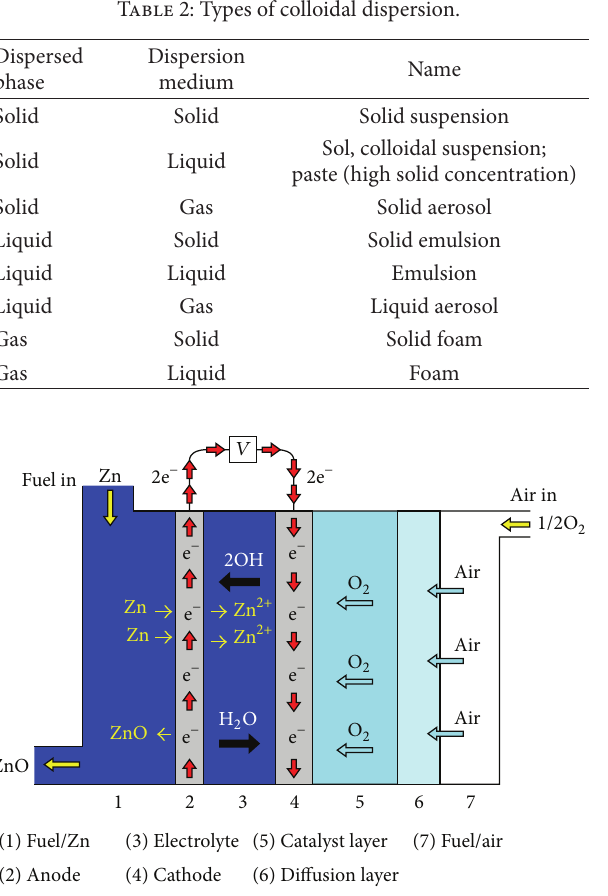
Figure 3: Working schematic of zinc-air fuel cell.